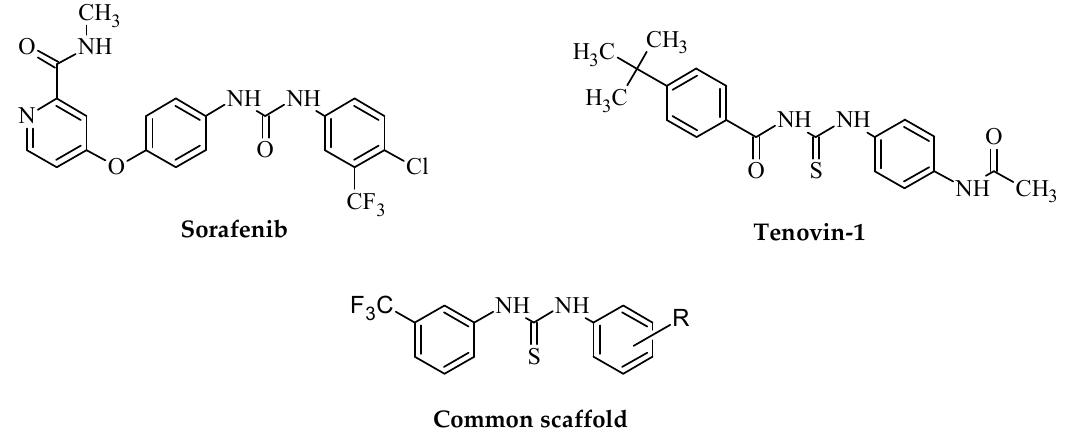
Figure 1. Anticancer agents derived from diaryl(thio)urea and the common scaffold of the designed target 3-